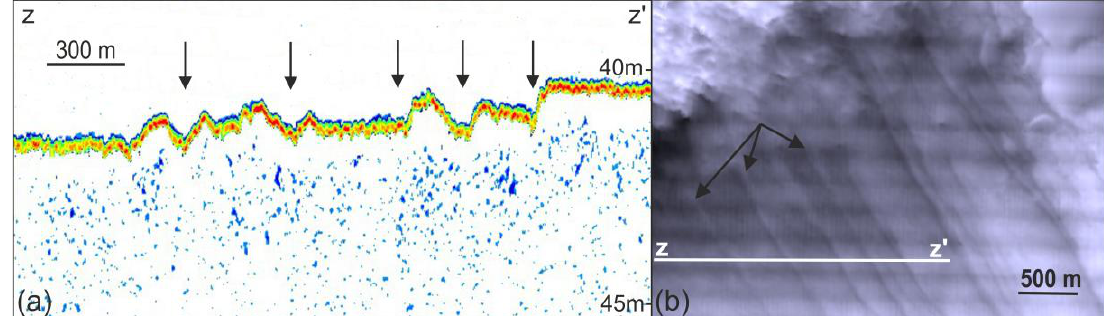
Figure 8. ( a ) Sub-bottom cross-section; ( b ) Multibeam bathymetry from Area 2. Black arrows point to the glacial linear features. Figure 6 for the location.